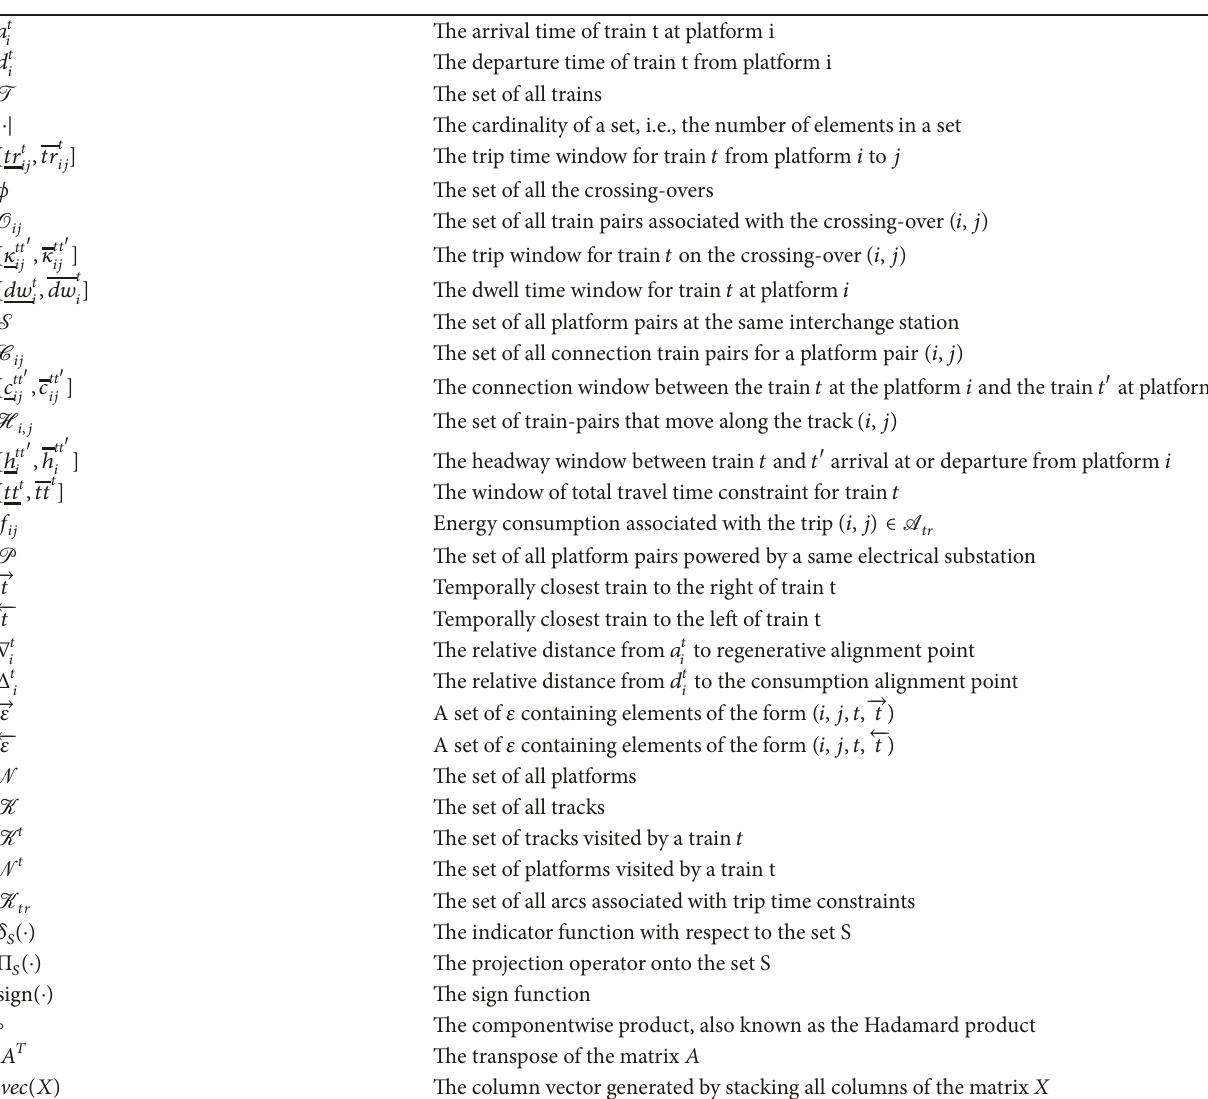
Table 1: A list of